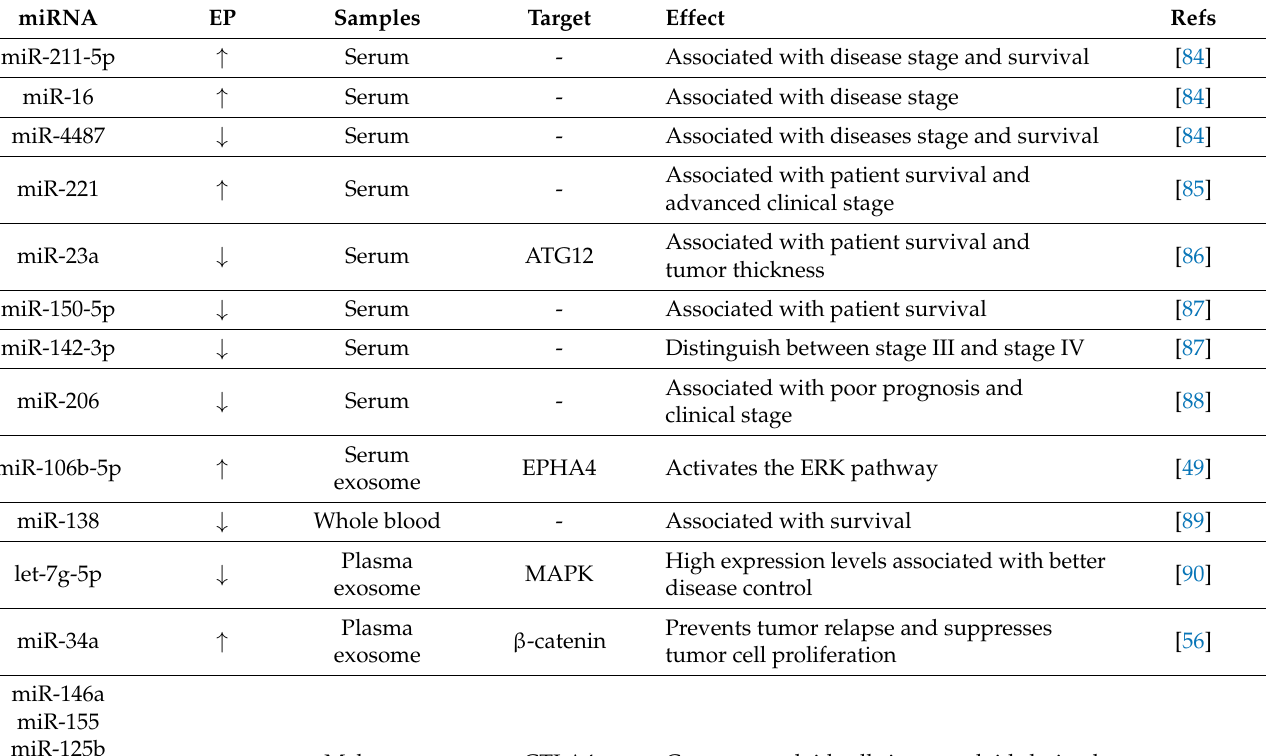
Table 2. Circulating miRNAs as potential markers for melanoma